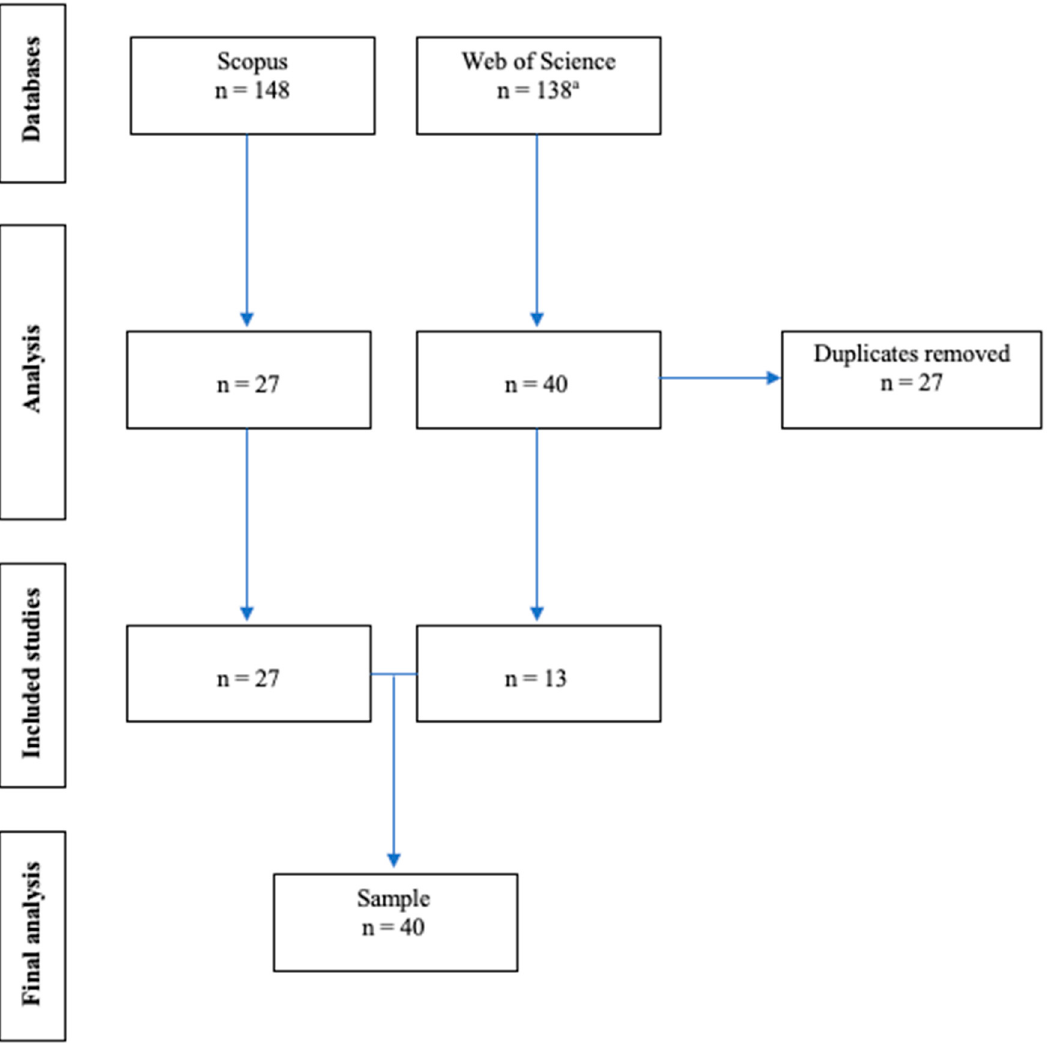
Figure 1. Design and search strategy. Note: (a) In the Web of Science search, articles were presented by categories, for example “fake news AND ideology” or “fake news AND conservative”, so some articles appeared in duplicate in other categories because the keywords refer to very similar